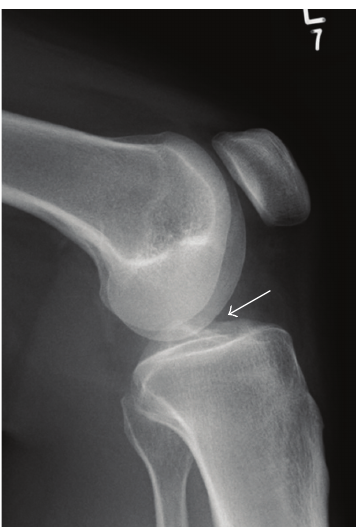
Figure 2: Lateral knee radiograph showing a soft tissue density lesion in the location of Ho ff a’s fat